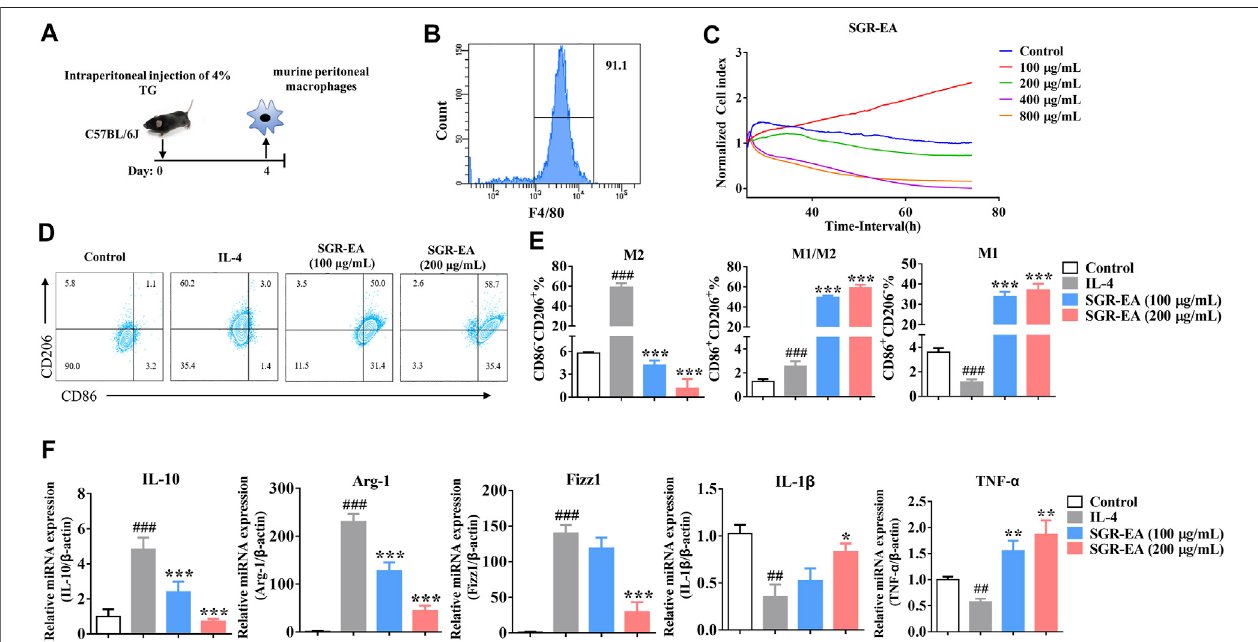
FIGURE 4 | SGR-EA resets the tumor-related M2 macrophages to the M1 phenotype in vitro . (A,B) Schematic diagram of murine peritoneal macrophage extraction and purity identi fi cation. (C) Real-time cellular analysis (RTCA) safe concentration range of SGR-EA. (D,E) Percentages of M1 and M2 in the macrophages weredetectedby fl owcytometry. (F) Expression levels ofIL-10, Arg-1, Fizz1, IL-1 β , and TNF- α in themacrophages were detected by qRT-PCR. Data areexpressed as the mean ± SD. ## p < 0.01 and ### p < 0.001 versus control. ** p < 0.01 and *** p < 0.001 versus model (IL-4).